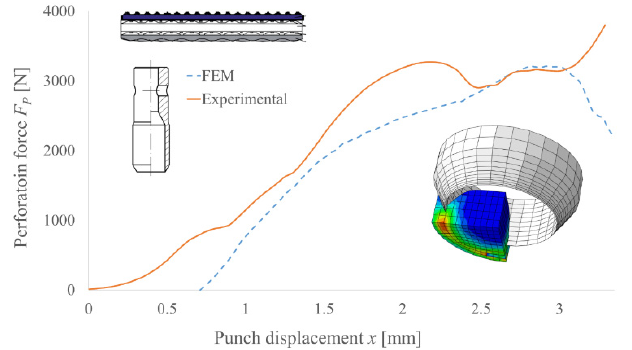
Figure 15. Comparison of the experimental and FEM analysis results of the perforation force for PO punch with diameter d = 10 mm and angle of the blade β = 30° for TFL10S belt.